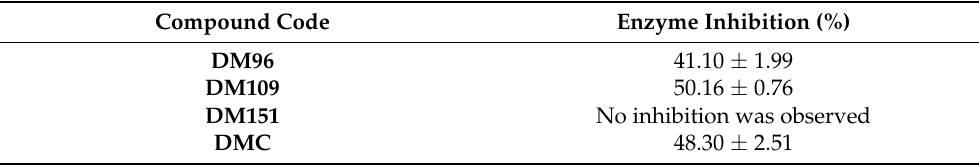
Table 3. Experimental data related to the potential of the most potent inhibitors (DM96, DM109, DM151, and DMC) to inhibit GST activity in DU-145 cell lysate.